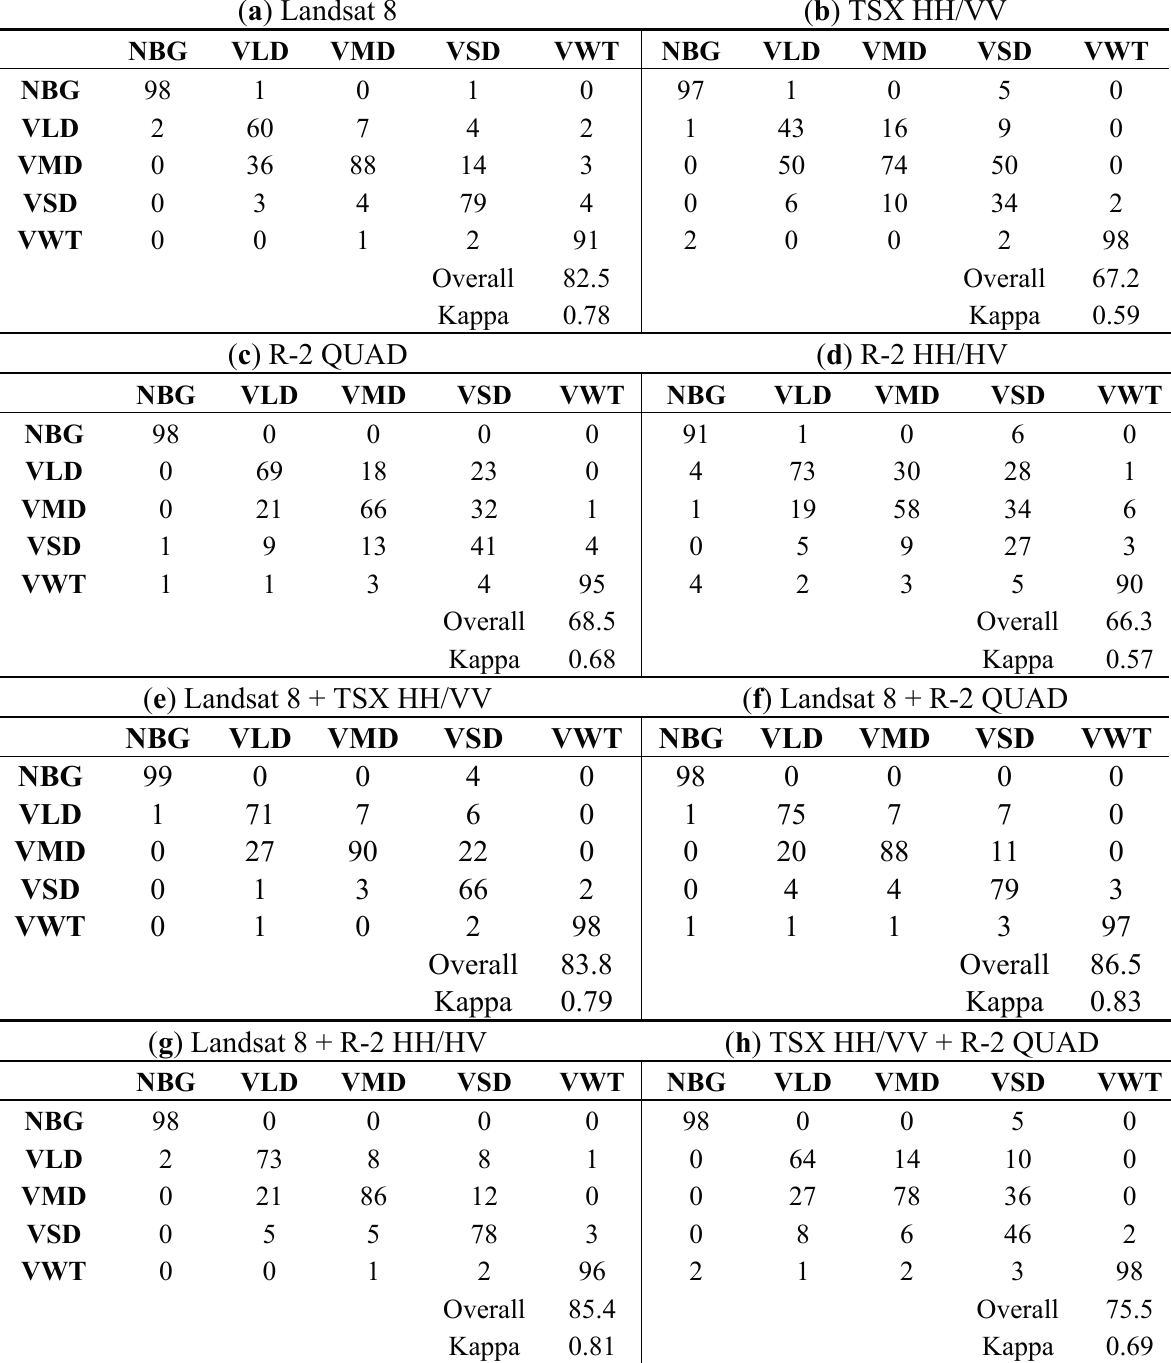
Table 3. Averaged Confusion Matrices from k-fold cross validation ( k = 5) for supervised land cover classification results ( a – h ). Accuracies are shown in percent